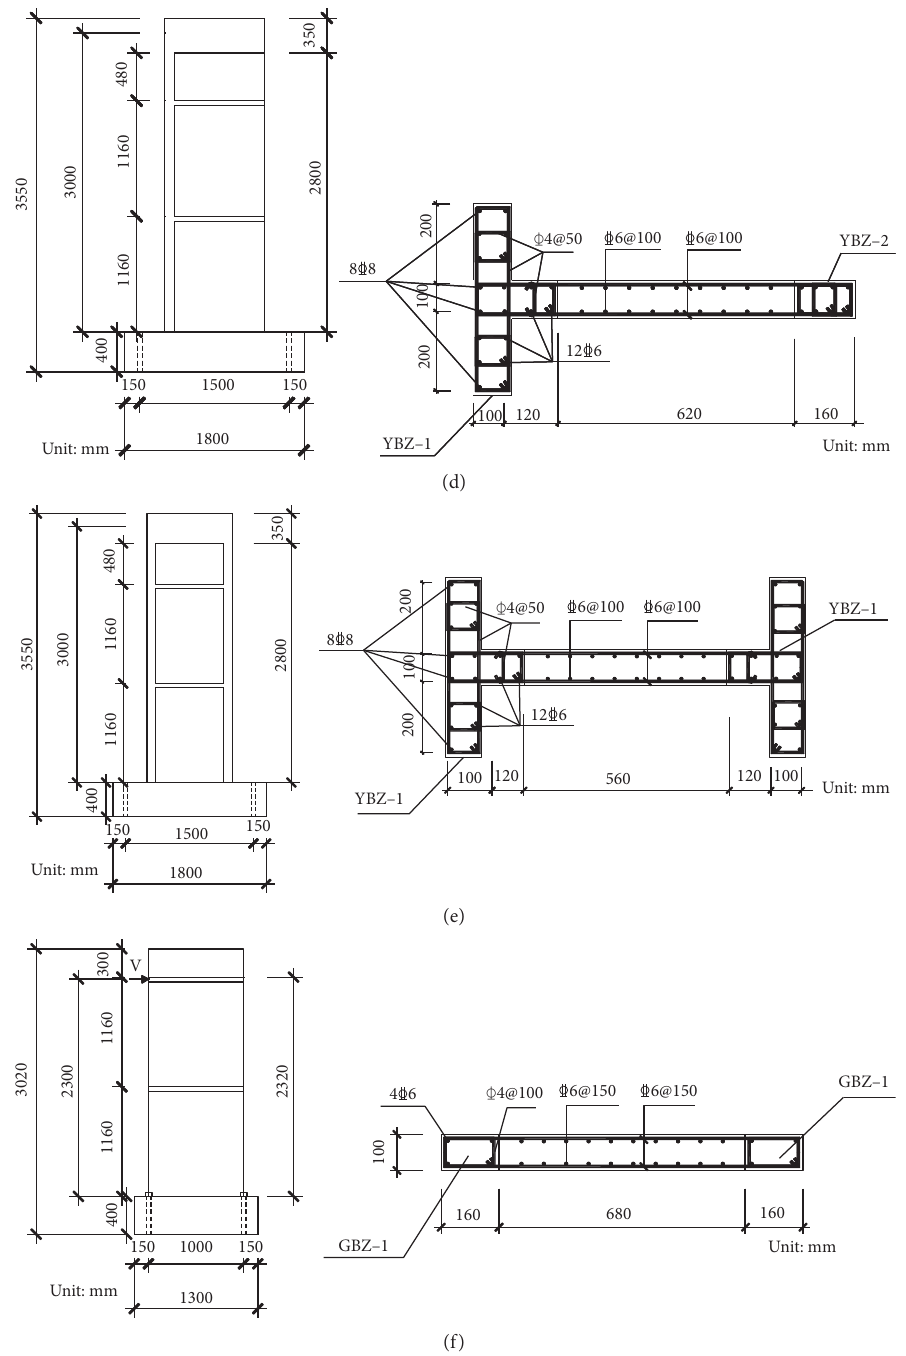
Figure 1: Design of specimens. (a) Design drawing of SW1 and SW2. (b) Design drawing of SW3. (c) Design drawing of SW4. (d) Design drawing of SW5. (e) Design drawing of SW6. (f) Design drawing of